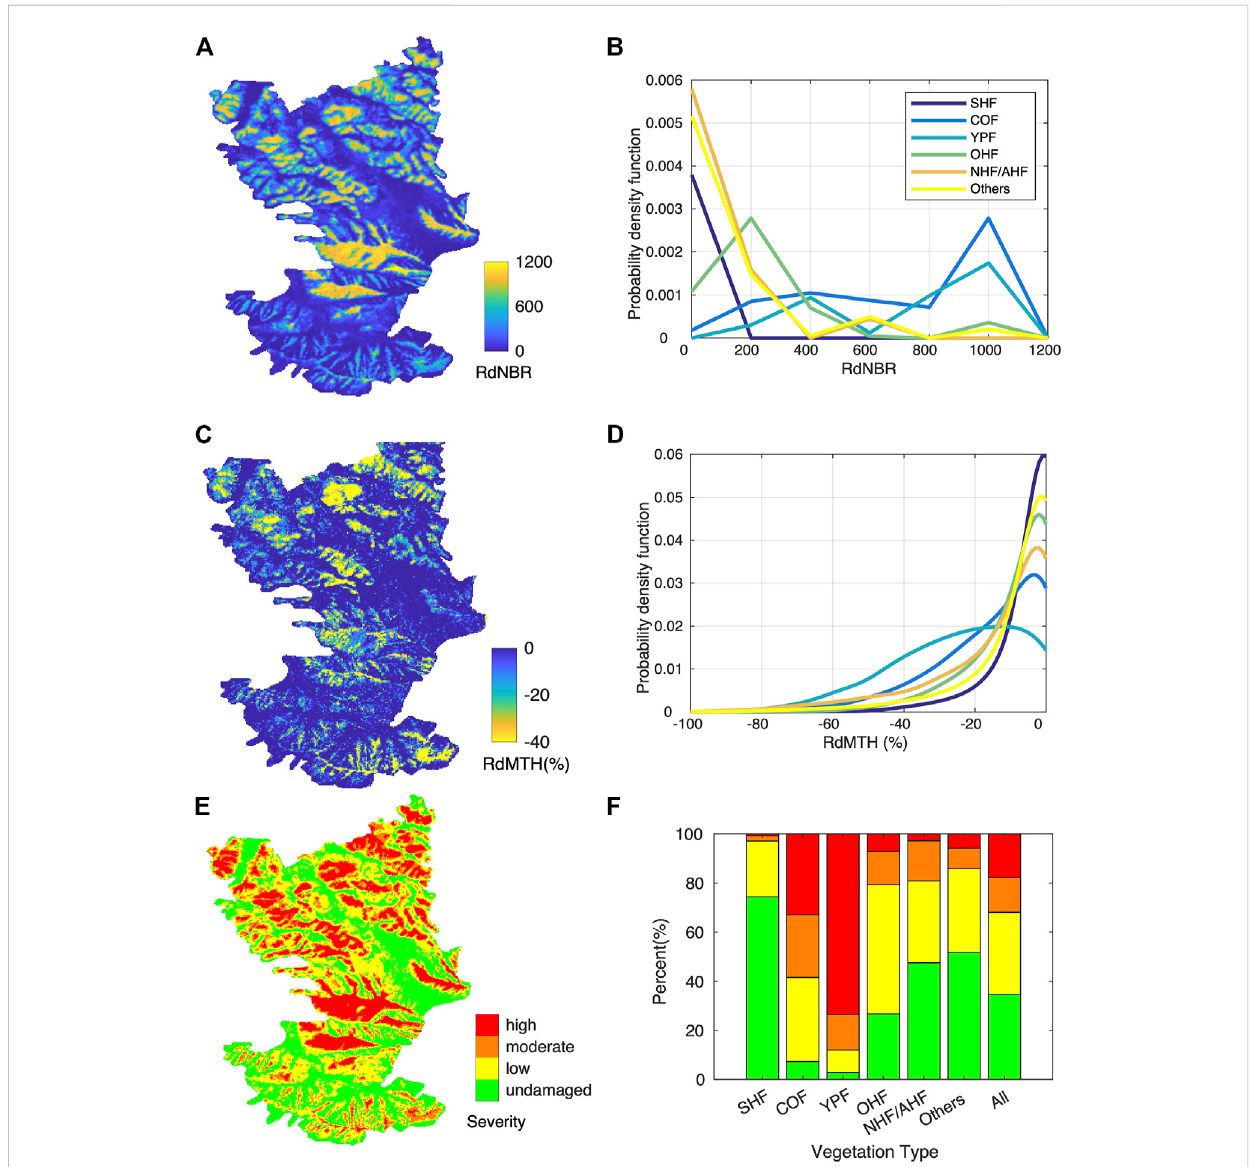
FIGURE 2 Spatial pattern of the relativized differenced Normalized Burn Ratio (RdNBR) (A) , relativized mean tree height (C) , and burn severity classi fi cation basedontheRdNBRthresholdsde fi nedbyMillerandThode(MillerandThode,2007) (E) .Probabilitydensityfunction(pdf)ofRdNBR (B) andRdMTH (D) by vegetation type classes. (F) Vegetation type speci fi c distribution of burn severity classes. Green, yellow, orange, and red stand for undamaged, low, moderate,andhighseverityclass.HF,COF,YPF,OHF,andNHF/AHFstandforsuccessionalhardwoodforest,chestnutoakforest,yellowpineforest, oak-hickory forest, and northern hardwood/acid hardwood forest,